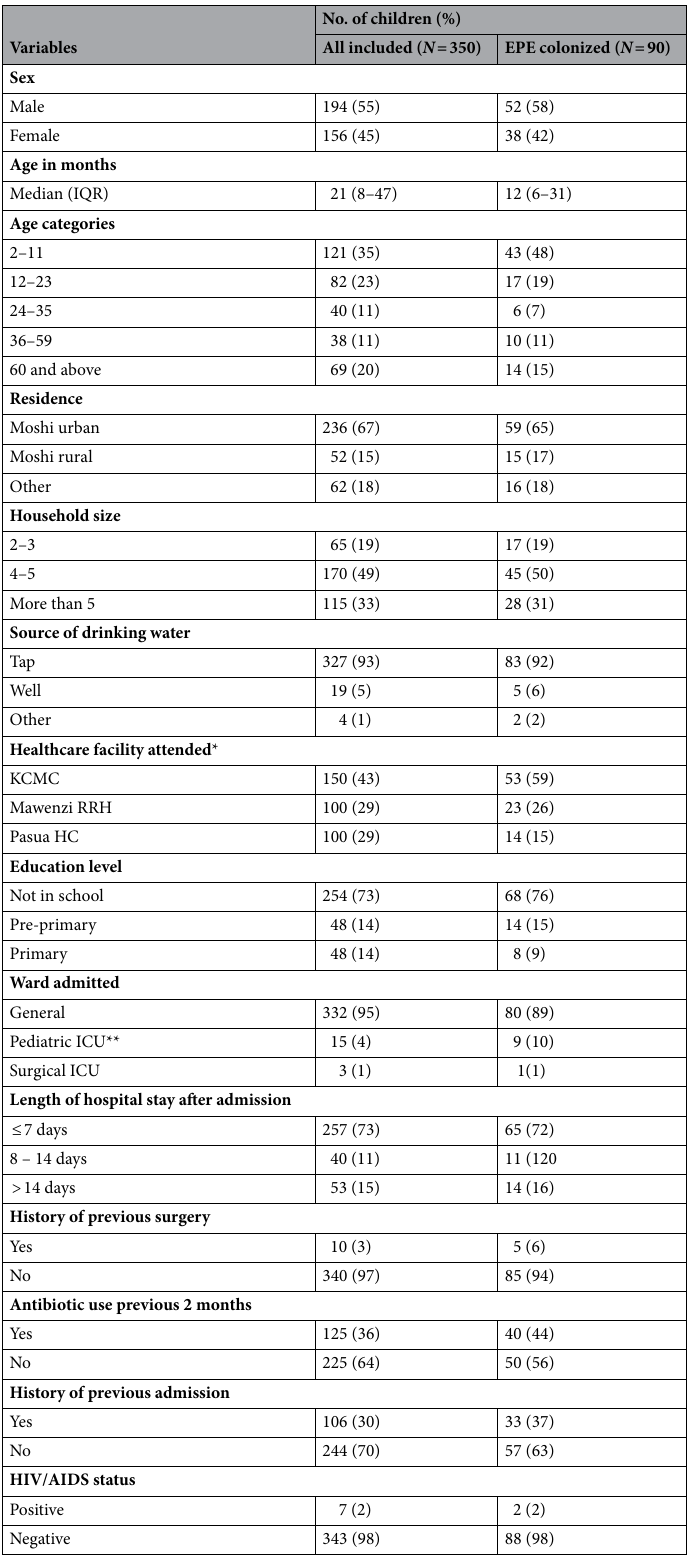
Table 1. General characteristics for those colonized with Extended-spectrum beta-lactamase (ESBL) producing Enterobacteriaceae (EPE) in feces at admission. * KCMC Kilimanjaro Christian Medical